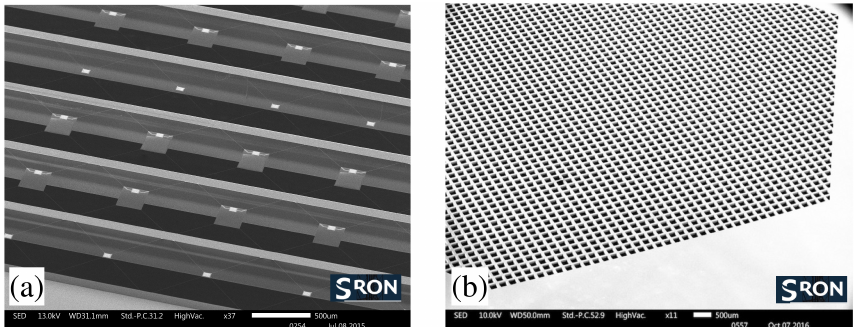
Figure 8. ( a ) SEM micrograph of an array of ultra-low-noise TES bolometers on suspended SiN structures with diagonal long legs (340 µ m × 0.5 µ m × 0.25 µ m) design. In the middle of each detector there is a TES and an absorber on a SiN membrane [101]. ( b ) Microphotograph of an array of thousands of square pockets etched by using a Si deep-RIE process. The pocket size is 190 × 190 µ m 2 and the pitch is 250 µ